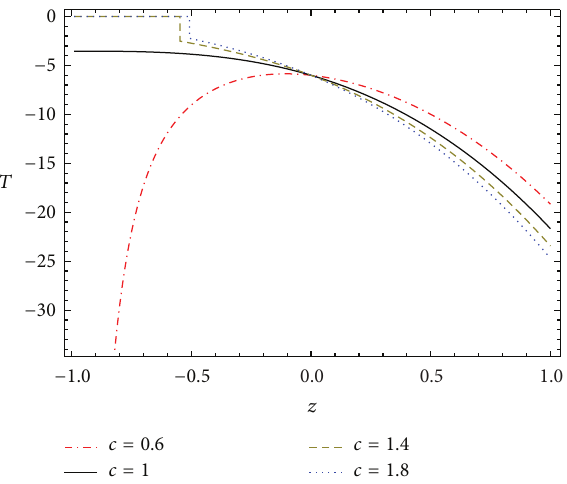
Figure 6: Future evolution of 𝑇 in HDE with Ω 𝑚0 = 0.315 , 𝐻 0 = 67.3 , and −1 ⩽ 𝑧 ⩽ 1